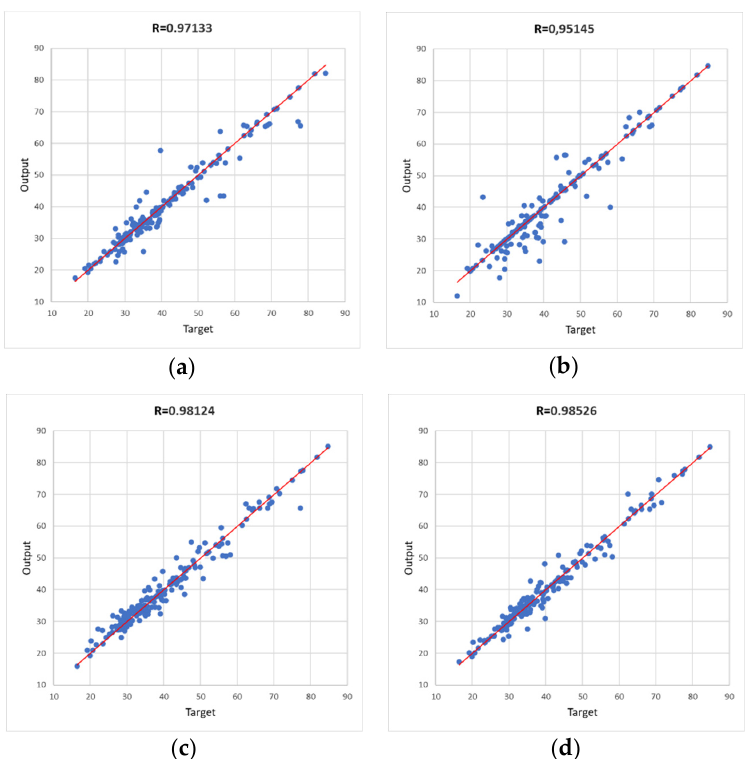
Figure 2. Correlations between target and output data for the four cases tested. ( a ): LM-15; ( b ): LM-20; ( c ) BR-15; ( d ): BR-20.